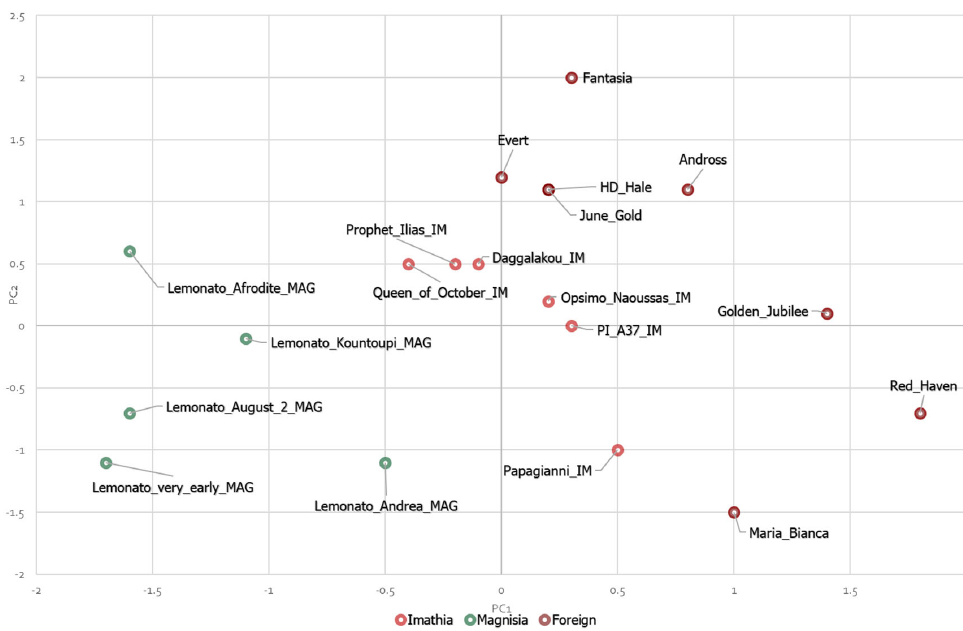
Figure 5. Segregation of 19 local and foreign peach cultivars on the basis of leaf and fruit physical and chemical characteristics determined by principal component analysis.